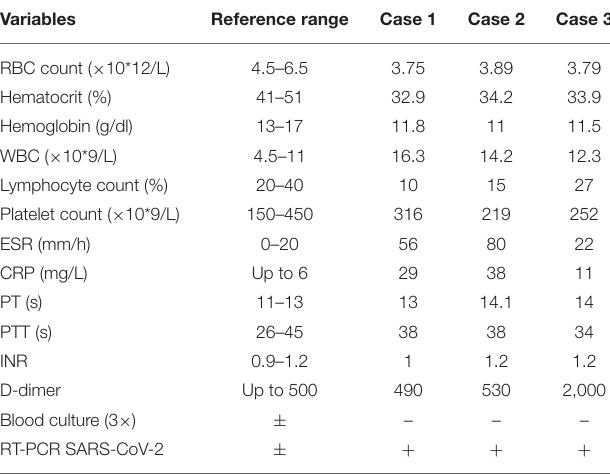
TABLE 1 | Laboratory test results of patients at the time of admission.